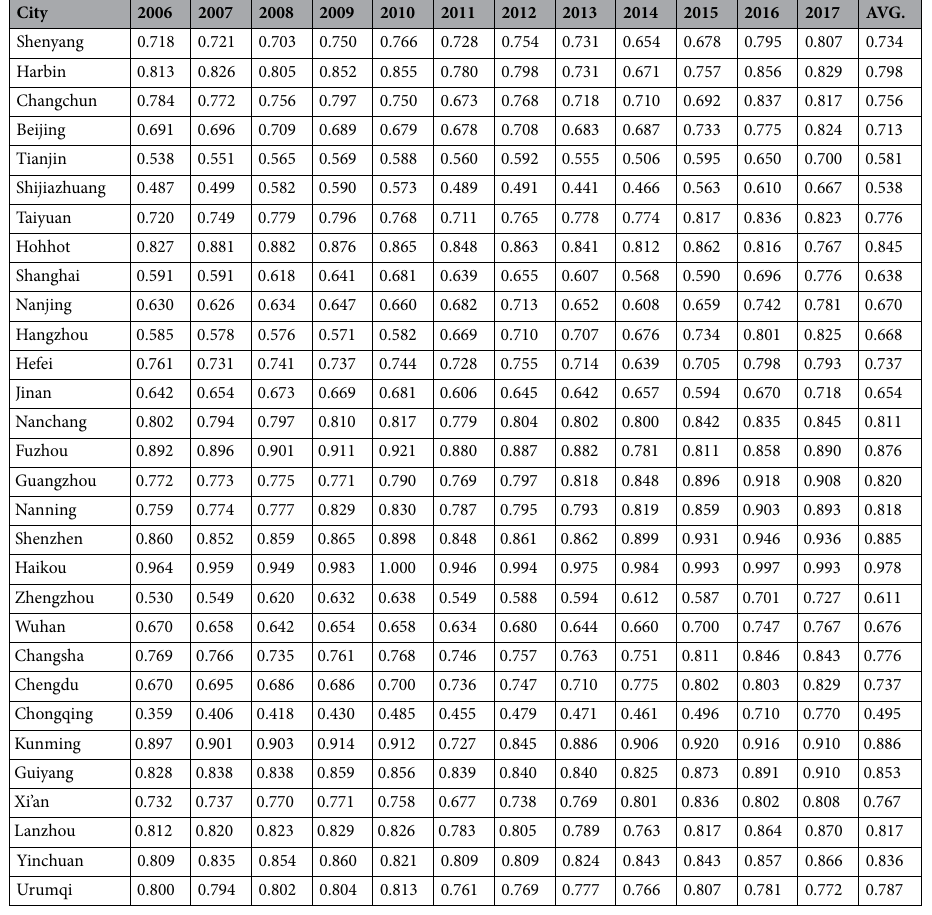
Table 3. environmental subsystem measure